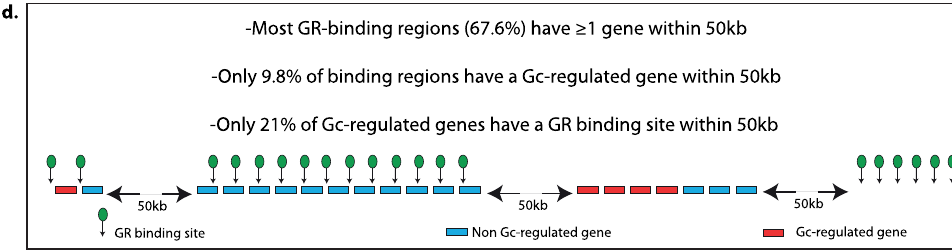
Figure 3. The GR cistrome. GR-binding sites (GBS) in human wild type podocytes were identified using ChIP- Seq and were analysed using the cis -regulatory element annotation system (CEAS). ( a ) Illustrates the percentage of GBS located in different functional genomic units. ( b ) The relation between GBS and the transcriptional output elicited by Gc-exposure identified by microarray was compared. The large pie chart shows division of GBS according to distance from Gc-regulated genes. Linked diagrams shows the percentage of GBS sites found in areas surrounding Gc –responsive and –unresponsive genes. Bar chart shows GBS enrichment in 2.5 kb promoter region over general genome background for Gc –responsive and –unresponsive genes. ( c ) Results of de novo motif enrichment on GR ChIP-Seq peaks using HOMER. The size of the letter for each nucleotide position relates to how dominant the base is for that